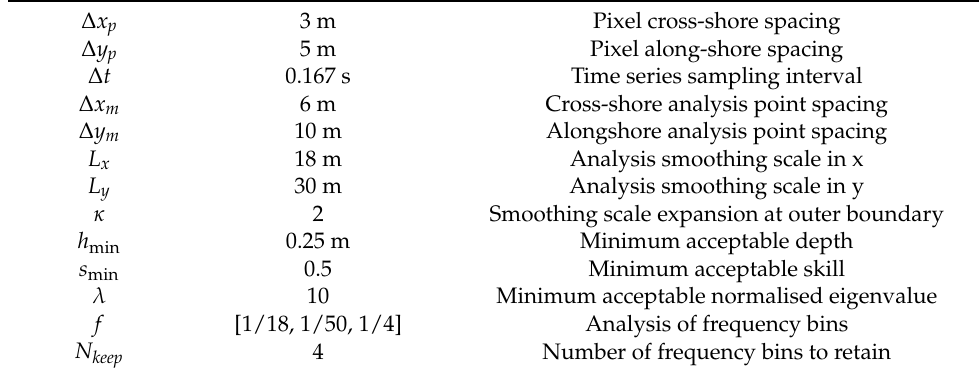
Table A1. cBathy